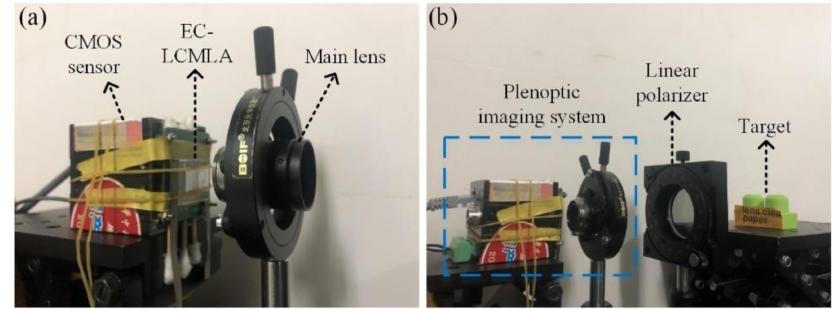
Figure 8. Photographs of: ( a ) The prototype of plenoptic imaging system, and ( b ) the experimental diagram for plenoptic imaging.